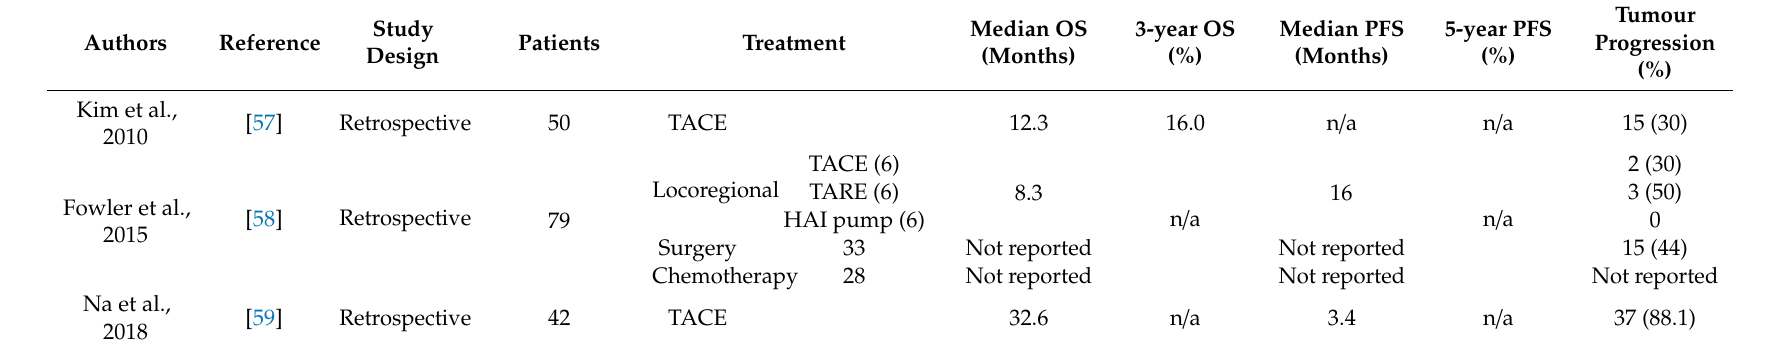
Table 2. Reported cohorts of patients treated with locoregional